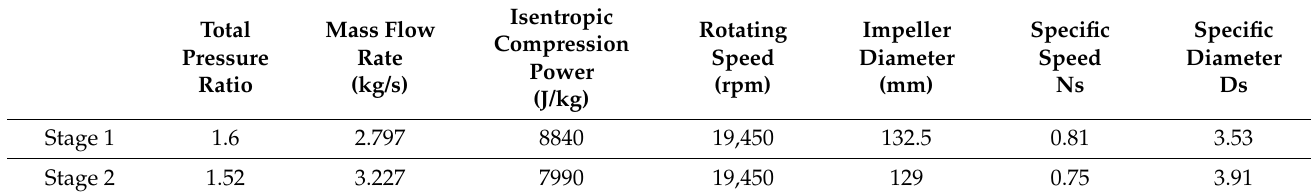
Table 3. USRT two-stage flow element concept design rotating speed and impeller diameter.